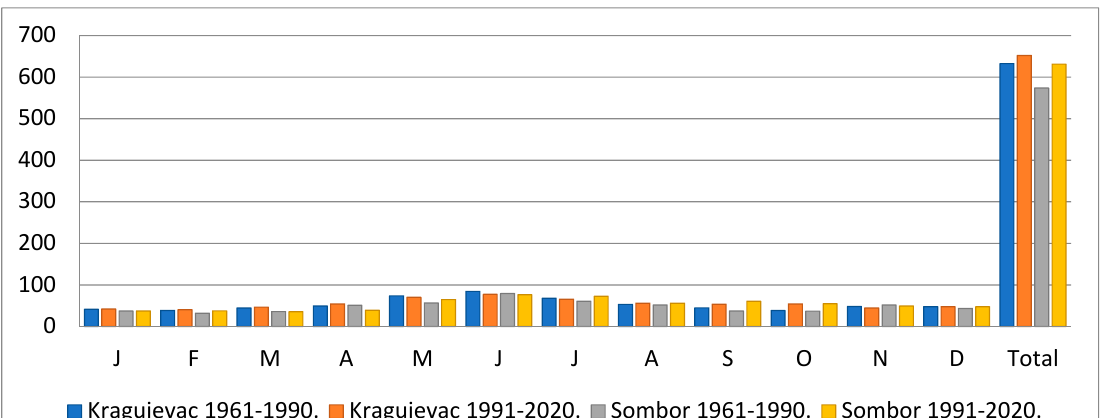
Figure 4. Amount of precipitation per year in Kragujevac and Sombor for the periods 1961–1990